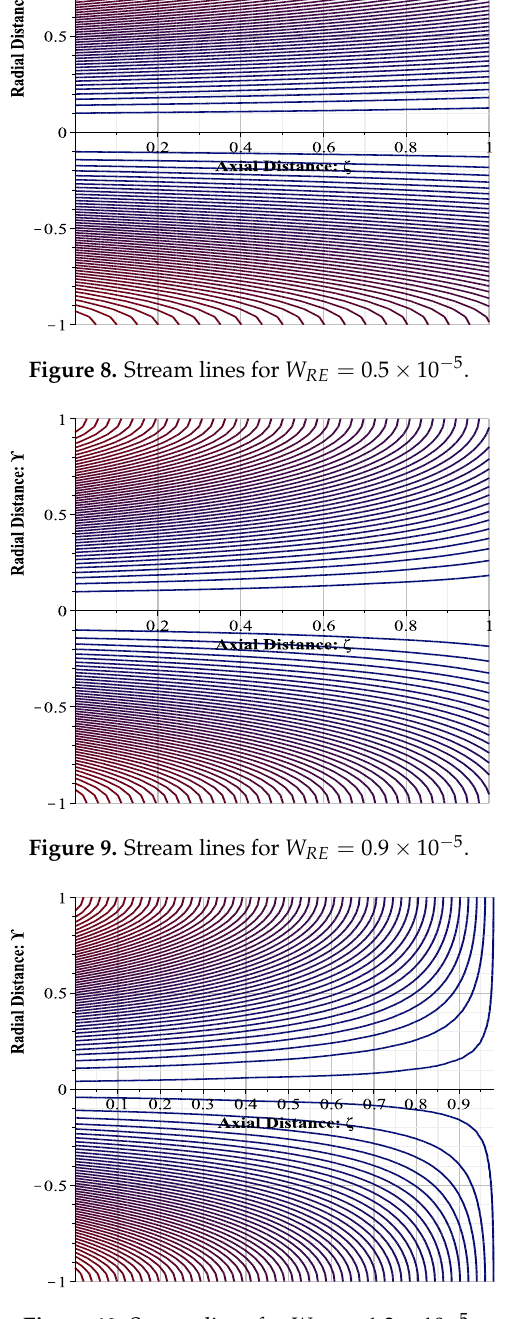
Figure 10. Stream lines for W RE = 1.3 × 10 − 5